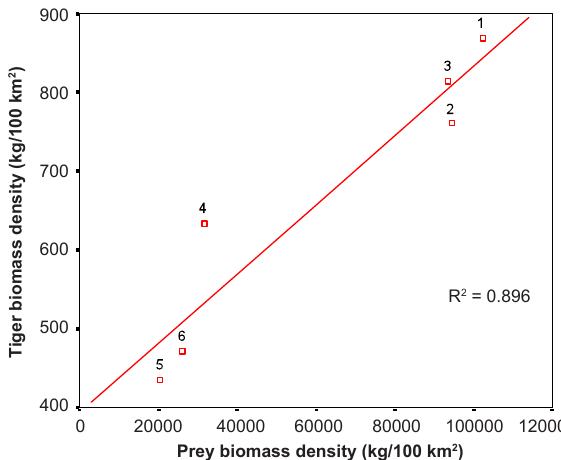
Figure 1. Comparison of tiger and large mammalian prey (spotted deer, wild boar and rhesus macaque) biomass densities (kg/100km 2 ) across six sites (1 - Katka-Kochikhali; 2 - Hironpoint; 3 - Mandarbaria; 4 - Harintana; 5 - Chandpai; 6 - Burigoalini) in the Sundarbans of